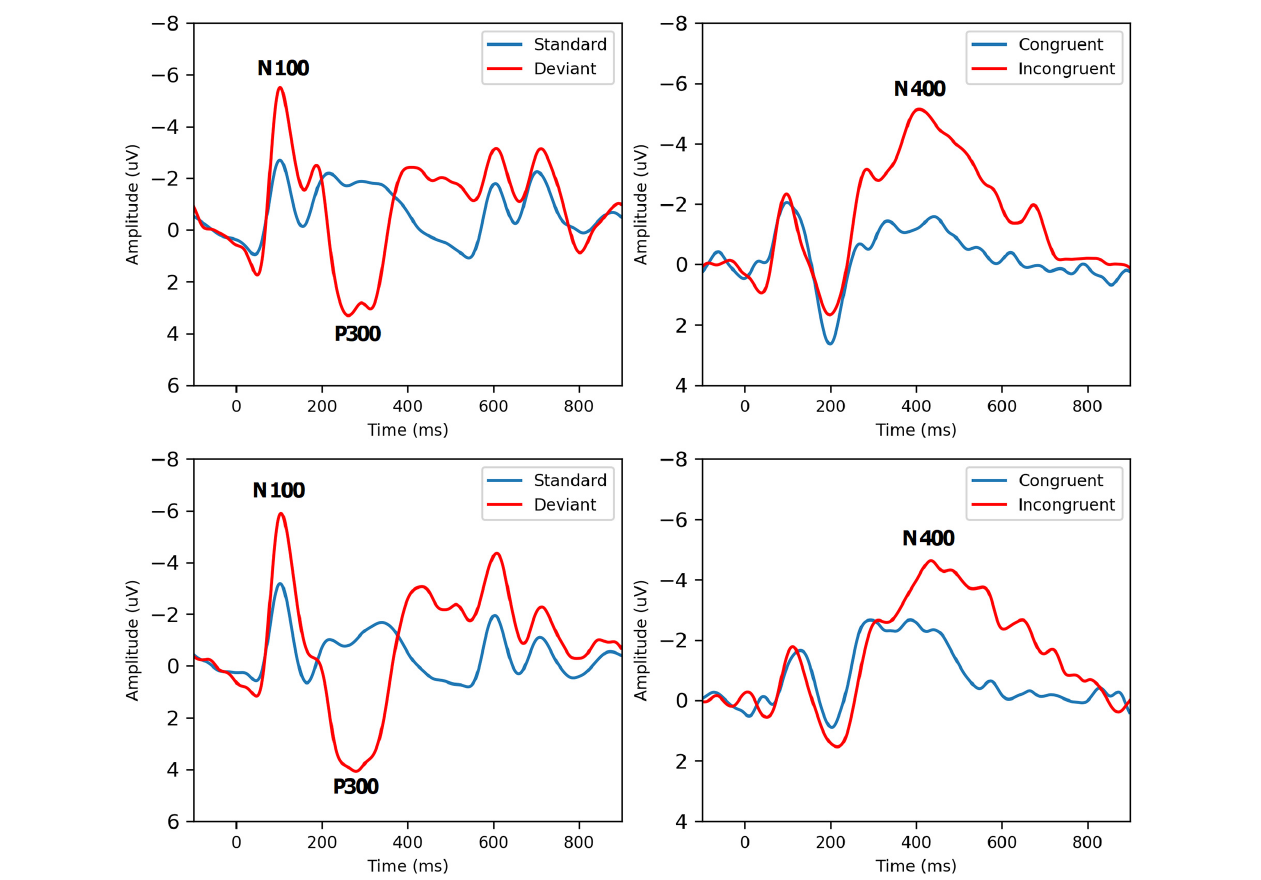
FIGURE 2 | Grand-Average ERPs to standard/deviant tones (left, N = 52) and semantic congruent/incongruent word pairs (right, N = 38) for Group A Time 1 (Top Row) and Time 2 (Bottom Row). Brain vital sign responses to the pattern changes in different tones (80% standard: low-frequency, low-amplitude, 20% deviant: high-frequency, high-amplitude) generate the well-established N100 and P300 ERP waves. Differences in semantic relationships between congruent (“bread-butter”) and incongruent (“bread-window”) word pairs elicit the N400 negativity. Refer to Ghosh Hajra et al. (2016) for a detailed description of how brain vital signs can be rapidly